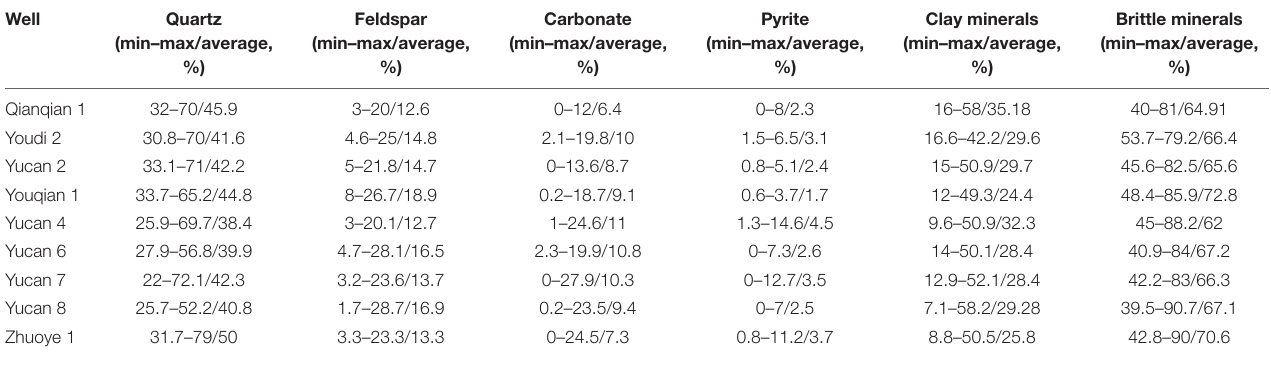
FIGURE 2 | Field sedimentary characteristics of the Wufeng–Longmaxi Formation shale. (A) shale at the Wulong–Jielong Section; (B) interface of Wufeng–Guanyinqiao Section–Longmaxi Formation at the Wulong–Jielong Section; (C) shale of the Youyang–Tianguan Section; (D) black carbonaceous mud shale at the bottom of the formation at the Tianguan Section in Youyang; (E) shale at the Majiaao Section in Xiushan; and (F) black carbon at the bottom of the formation at the Majiaao Section in Xiushan mudstone. TABLE 1 | Mineral composition of organic-rich shale from the Wufeng–Longmaxi